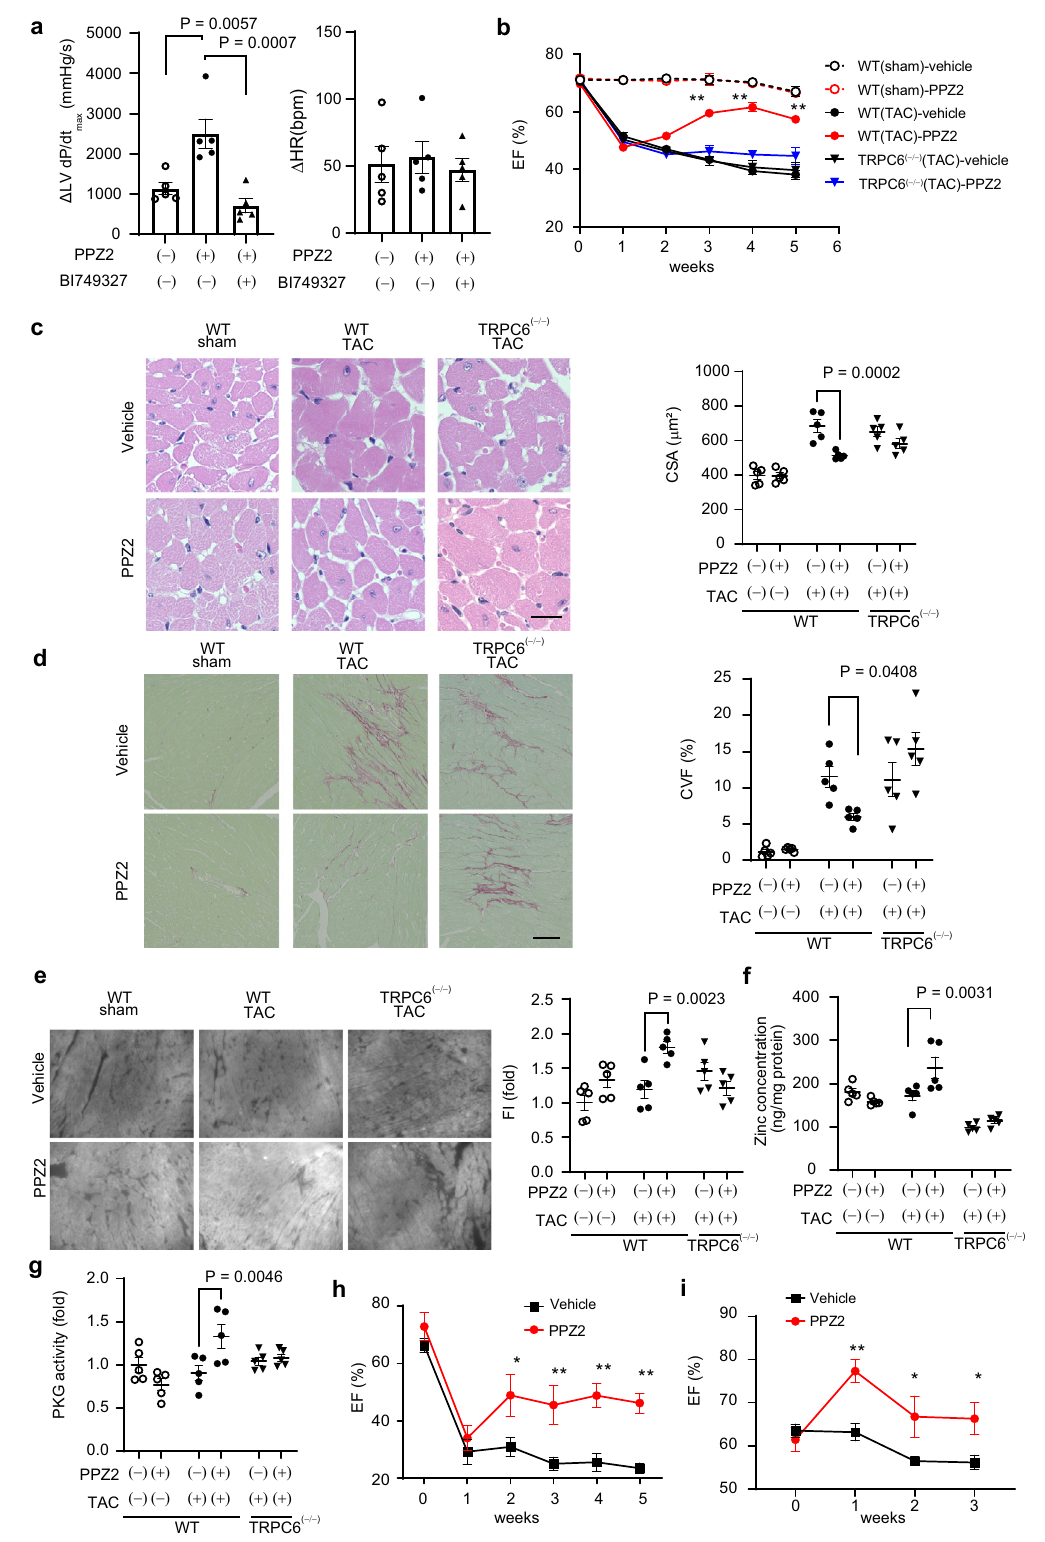
were transfected with plasmid DNAs using X-tremeGENE9 (Roche) and on poly-L-lysine (Sigma)-coated glass coverslips or 35mm glass